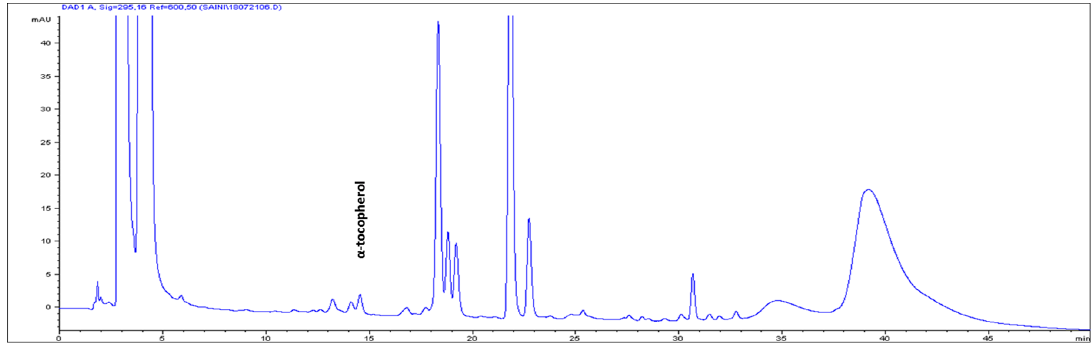
Figure 3. High-performance liquid chromatograms (HPLCs) (295 nm) of α -tocopherol in the leaf tissues of Mertensia maritima . Table 4. Carotenoid and tocopherol contents in the leaf tissues of Mertensia maritima .